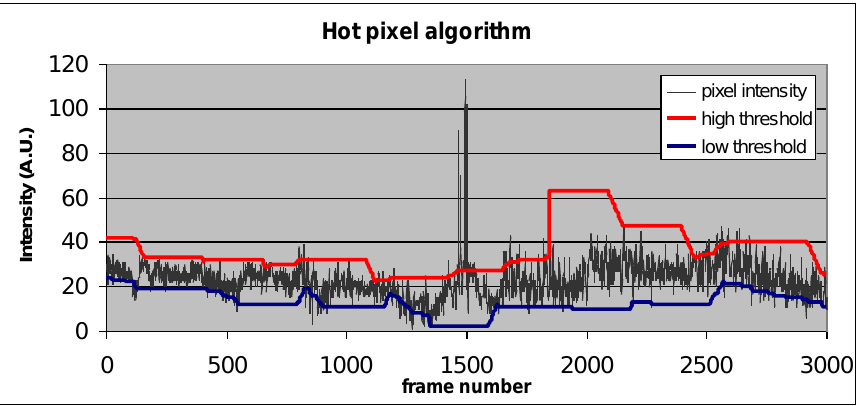
Figure 3. Hot pixel algorithm, showing the high and low thresholds and their adaptive behavior as a function of pixel intensity